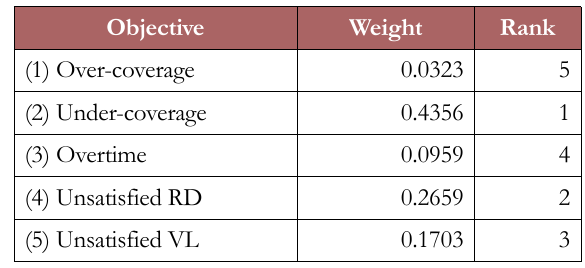
Table 9. Weights of the objectives used and their ranking